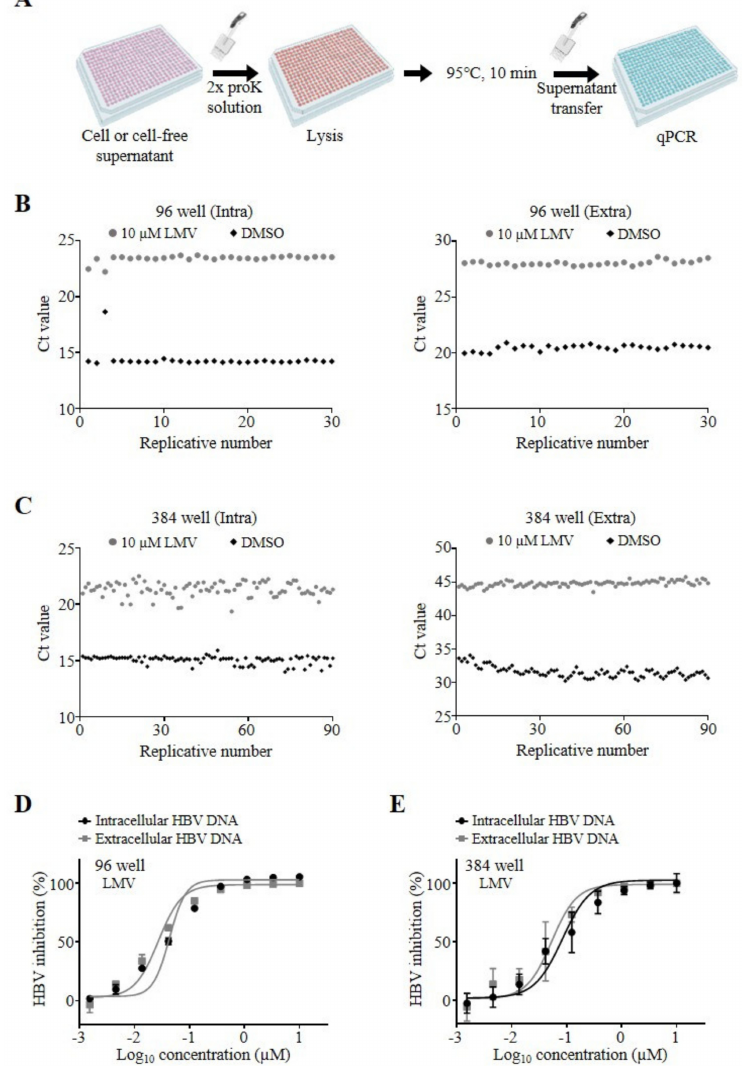
Figure 3. Assay validation in microtiter plates. ( A ) Schematic workflow of column-free DNA preparation in microtiter plates. HepAD38 cells were prepared and treated with LMV, as described above. Cells or cell-free supernatants in 96- or 384-well microtiter plates were lysed and subjected to the same plate format for qPCR analysis. HepAD38 cells were plated in 96- or 384-well microtiter plates at 1 × 10 5 cells / well ( B ) and 2.5 × 10 4 cells / well ( C ), respectively. Hepatitis B virus (HBV) DNA was prepared from cells (Intra, left) or supernatants (Extra, right) using the column-free method and analyzed by qPCR. Replicative numbers and C t values of controls treated with DMSO (black diamonds) or 10 µ M LMV (gray circles) are depicted as scatter plots on the x - and y -axes, respectively. ( D , E ) Dose–response curve analysis of intra- (black circles) and extracellular (gray squares) HBV DNA by LMV treatment of HepAD38 cells in 96- ( D ) or 384-well ( E ) plates. HBV DNA was analyzed by qPCR and normalized as described above. The concentrations of compounds in log scale and percent HBV inhibition are depicted on the x - and y -axes, respectively. Representative data of two independent experiments are shown as mean ± standard deviation